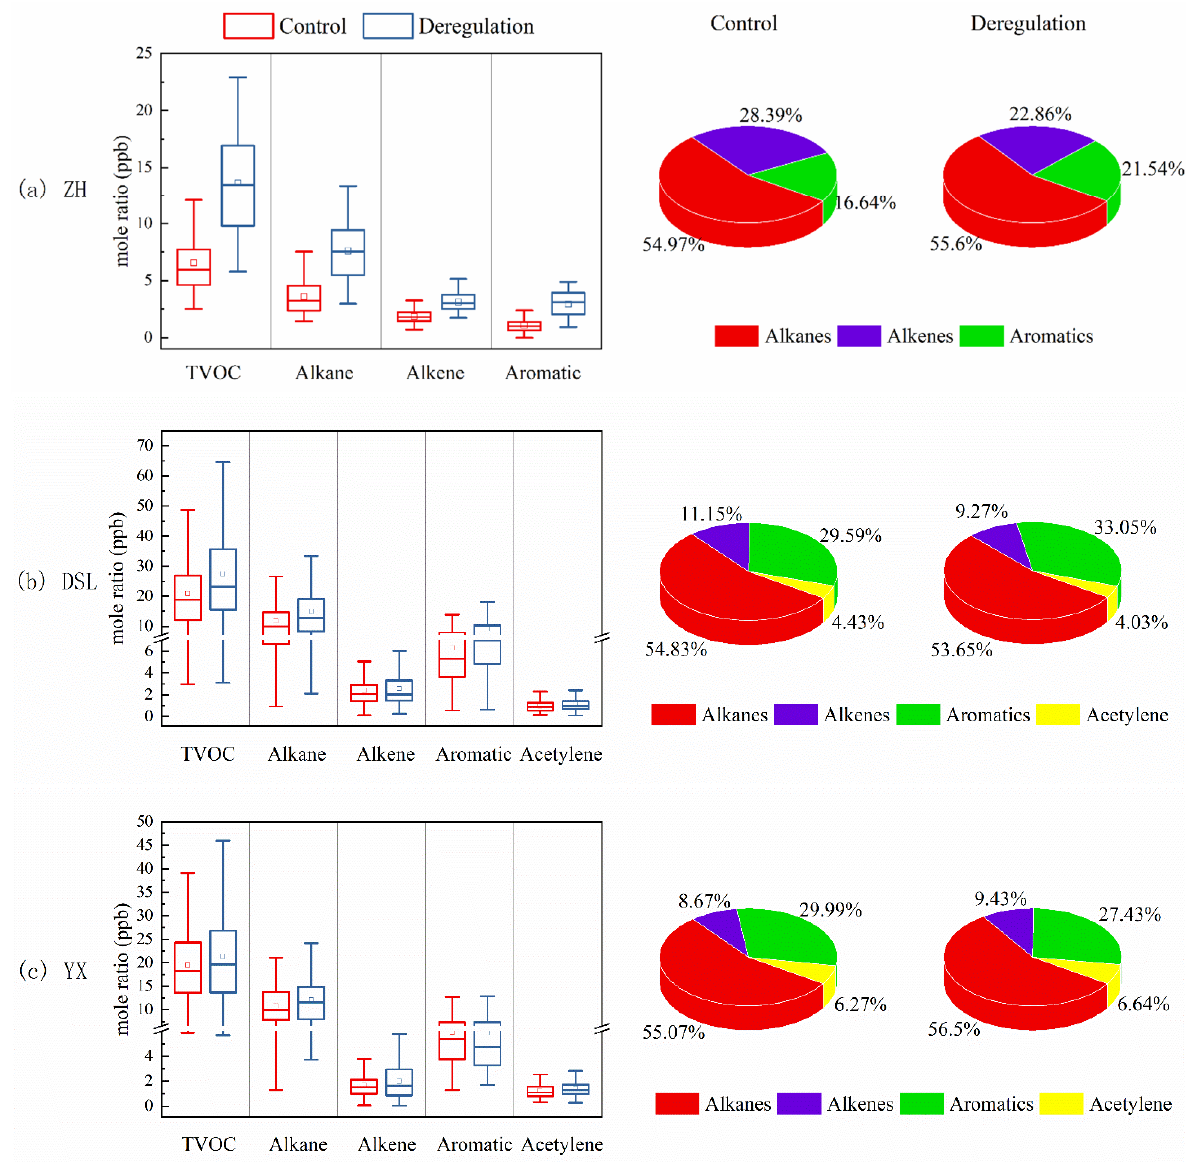
Figure 6. The mole ratios and percentage of VOC chemical compositions during different periods at the ZH ( a ), DSL ( b ) and YX ( c ) sites.